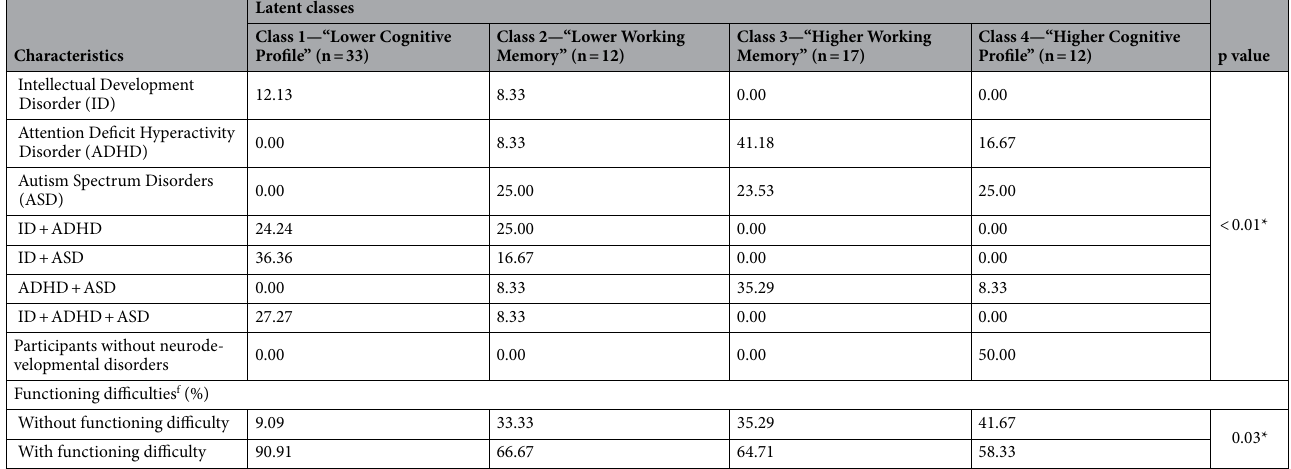
Table 3. Comparison of child, parent, household, and clinical variables across the four latent classes, Psychiatric Children’s Hospital, Mexico City, Mexico, 2017–2019 (n = 74). a Mother’s or Father’s